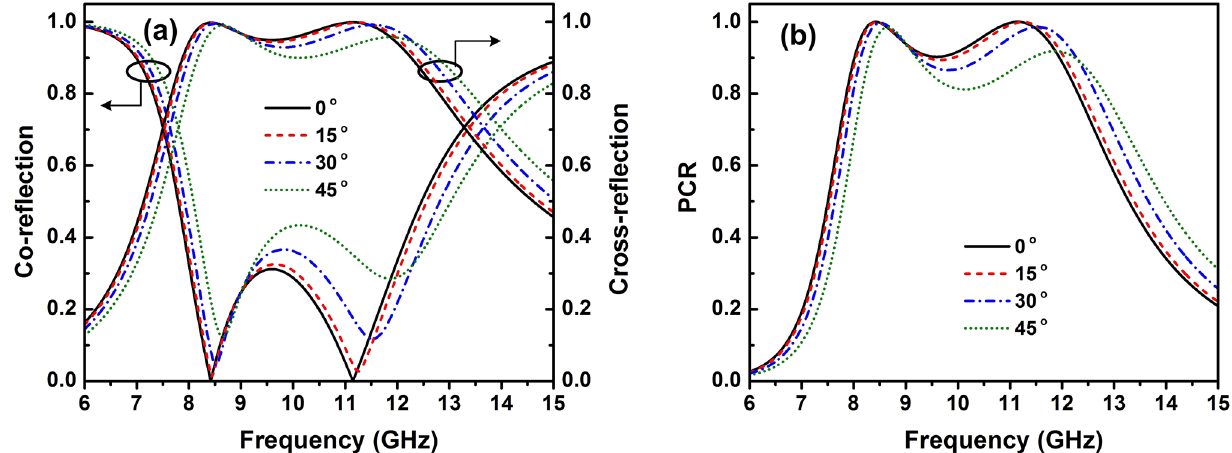
Figure 3. ( a ) Magnitude of co- and cross-polarized reflection coefficients and ( b ) PCR of the proposed polarization converter under incident angles ranging from 0 ◦ to 45 ◦ for TE